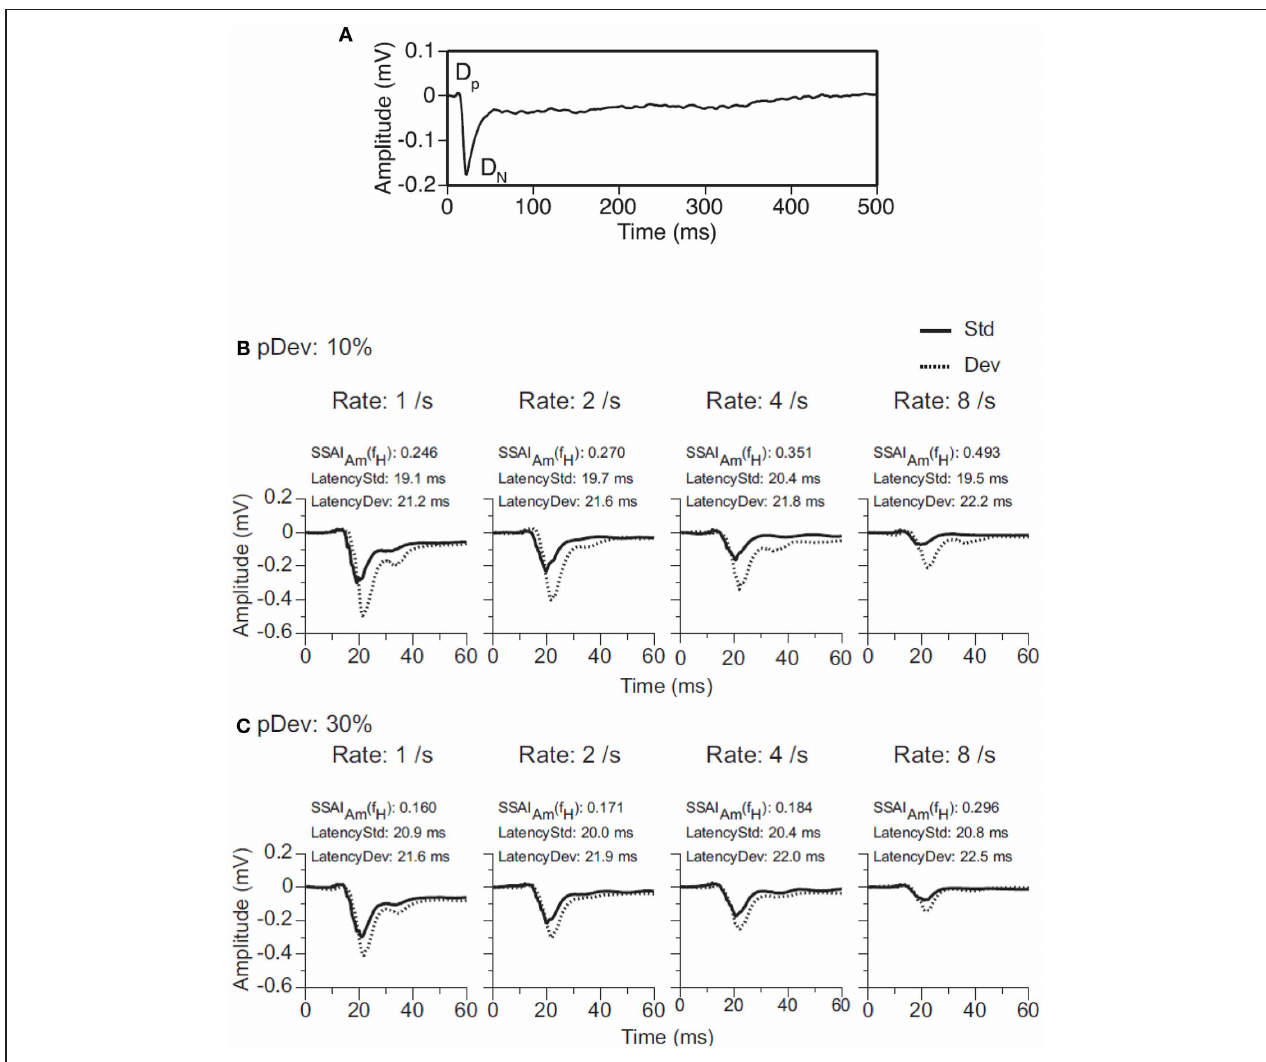
(panel C ). Data were obtained for pairs of tones ( f 1 = 2 . 25kHz and f 2 = 3 . 24kHz.) separated by a (cid:2) f = 0 . 37 and presented at 1, 2, 4 and 8Hz. The BF of the recording site was 2.7kHz. An amplitude-based, frequency-specific, stimulus-specific adaptation index [SSAI Am ( f X )], along with the peak latencies of the responses evoked by the sound as standard and deviant stimuli, is shown at the top of each graph. Reproduced from Patel et al.